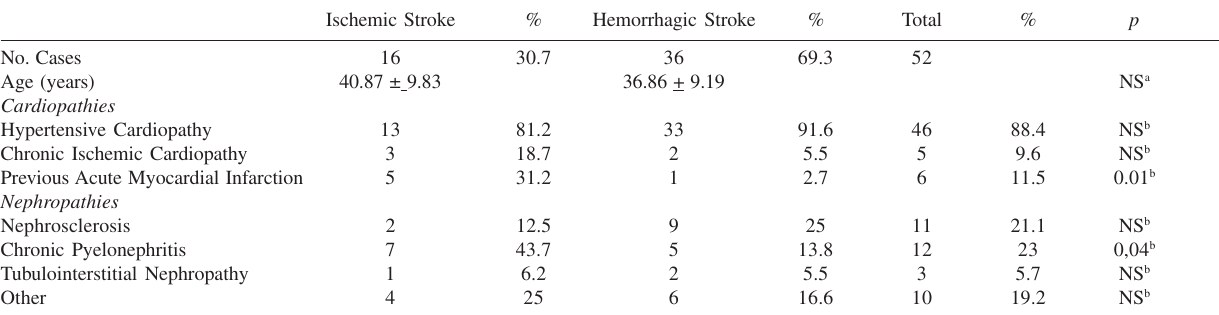
Table 1 - General Data related by Age, Principal Cardiopathies and Nephropathies for Stroke in Young People. Ischemic